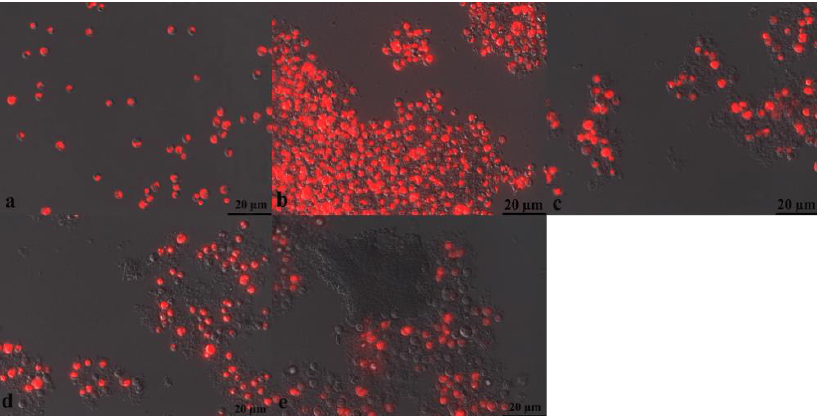
Figure 6. Fluorescence microscopy (FM) image of microalgae. ( a ) Fresh microalgae cell without any treatment, ( b ) microalgae cell with FeSO 4 addition, ( c ) microalgae cell with 15 min electro-Fenton treatment, ( d ) microalgae cell with 37 min electro-Fenton treatment, ( e ) microalgae cell with 1 h electro-Fenton